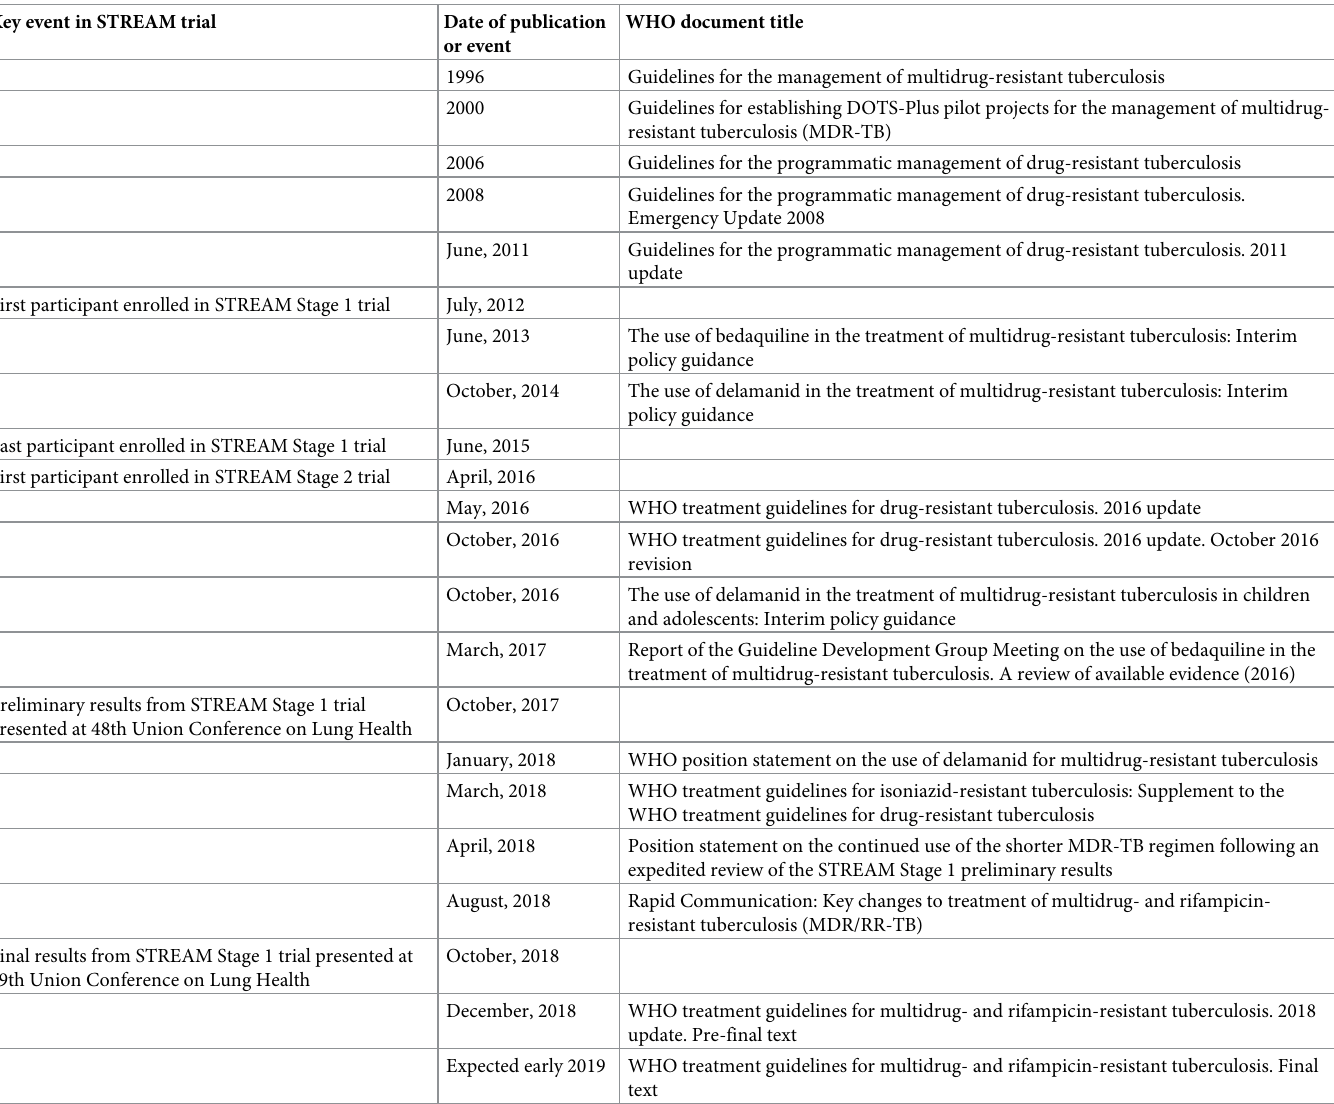
Table 1. Summary of WHO guidelines, policies, and statements on the treatment of DR-TB. Guidelines for the treatment of DS-TB are not included because these have remained largely unchanged in this period. Key dates are also included from the case study of the STREAM trial, a trial comparing a 9- to 11-month regimen contain- ing high-dose moxifloxacin and clofazimine with the 20- to 24-month WHO-recommended standard of care regimen for MDR-TB, which is discussed further in Box 1